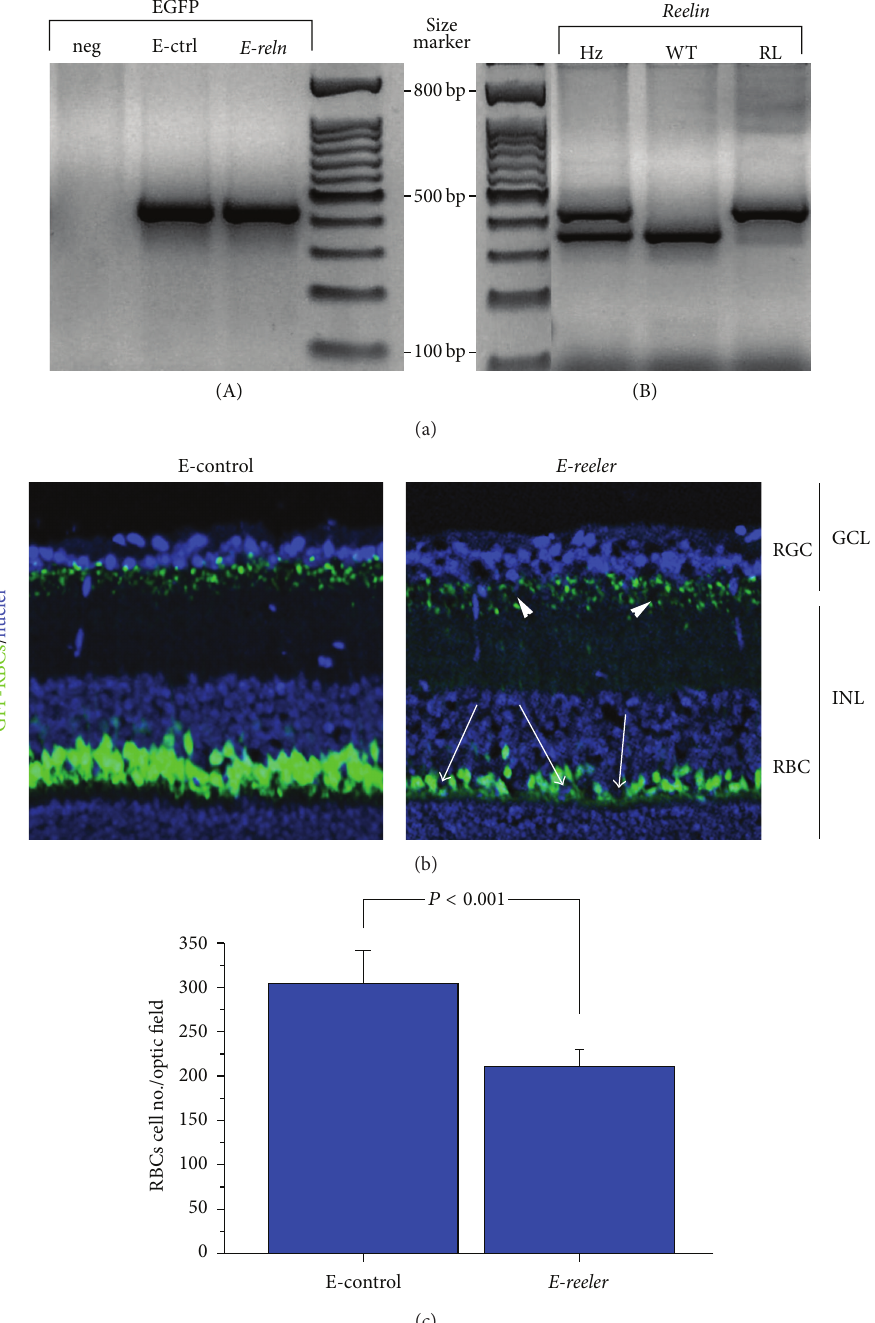
Figure 1: E-reeler model. (a) Agarose gel representative of EGFP and Reelin gene amplification. (A) EGFP expression in E-control (E-ctrl) and E-reeler ( E-reln ) tail genome, with respect to negative control (neg), not expressing GFP linked to L7-EGFP construct; (B) Reelin expression in control (WT), heterozygote (Hz), and reeler (Rl). The higher band (380bps) represents reeler status while the lower one (280bps) represents control rank. (b) Representative confocal microscopy image showing GFP-expressing RBCs (green) and nuclei stained with TOTO3-Iodide (blue). A decrease in the number of RBCs populating the INL is visible in E-reeler retina (arrows), as compared to E-control counterpart. Note the reduction of GFP-fluorescence of both the dendrite length and synapses (GFP staining) indicated by arrowheads in the E-reeler retinas ( × 400). (c) Number of GFP-bearing RBCs in E-reeler retinas, compared to the E-controls. Note the significant decrease of fluorescent cells ( 𝑃 < 0.001 ). Abbreviations: GFP, Green Fluorescent Protein; RGCs, Retinal Ganglion Cells; INL, Inner Nuclear Layer; RBCs, Rod Bipolar